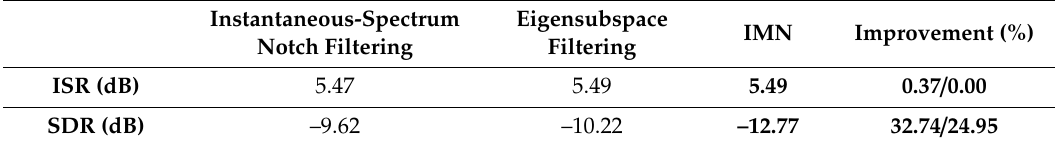
Figure 10. Representation in the time–frequency domain. ( a ) STFT of the WBI-free pulse. ( b ) STFT of the simulated WBI-corrupted pulse. ( c ) STFT after the instantaneous-spectrum notch filtering. ( d ) STFT after the eigensubspace filtering. ( e ) STFT after the IMN. Table 4. Comparison for the WBI-contaminated echo.